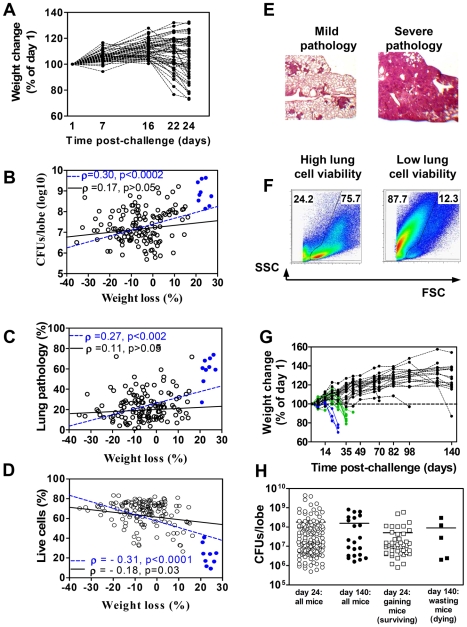
F2 mice display different rates of TB progression.F2 mice were challenged i.t. with 103 CFU of Mtb. Weight was monitored once a week. A, Kinetics of weight change. 100% - weight on day 1 post-infection. Shown are representative results obtained in two (n = 52) independent experiments that included mice of both sexes. B–D, Mycobacterial load (B), lung pathology (C), and lung cell viability (D) in mice displaying different degree of wasting. Severely wasting mice (wasting by more than 20%) are indicated by blue circles. Lines show the predictions of the linear regression when all mice are included in the analysis (dashed blue lines) or when severely wasting mice are excluded from the analysis (solid black lines). ρ, Spearman correlation coefficient; p, p-value for ANOVA. E, F, Examples of lung tissue sections and lung cell flow cytometry representing two extremes with mild and severe pathology. Numbers in F indicate the percentages of dead (left) and live (right) cells. G, H, Long-term monitoring of F2 mice (n = 30, two independent experiments). G, The kinetics of weight change. H, Comparison of mycobacterial loads observed on days 24 and 140 post-infection.